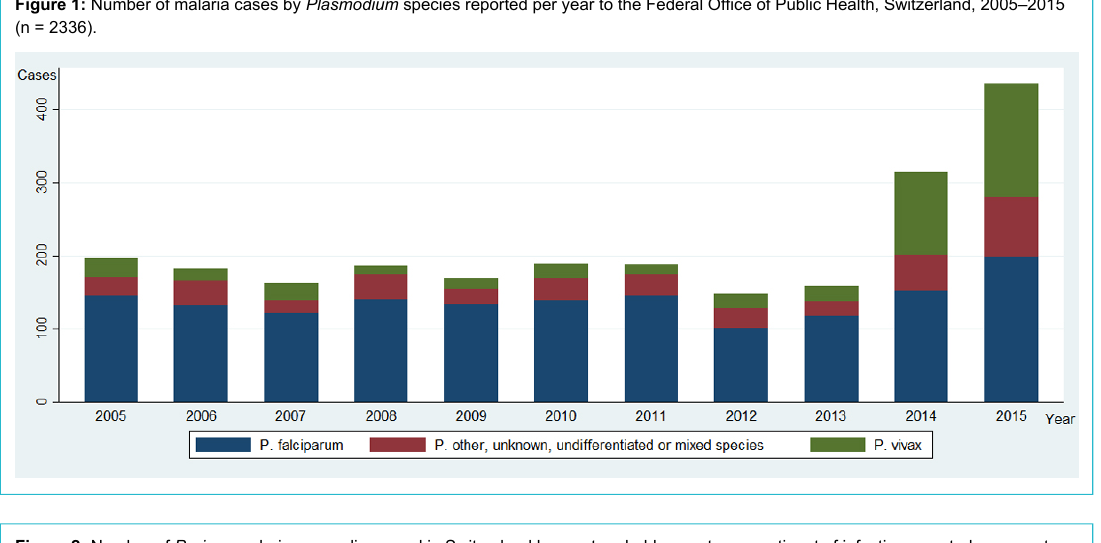
Figure 2: Number of P. vivax malaria cases diagnosed in Switzerland by most probable country or continent of infection reported per year to the Federal Office of Public Health, 2005–2015 (n = 437).“Multiple countries in the Horn of Africa” represents ≥ 2 countries among Eritrea, Ethiopia, Somalia, Sudan and South Sudan.